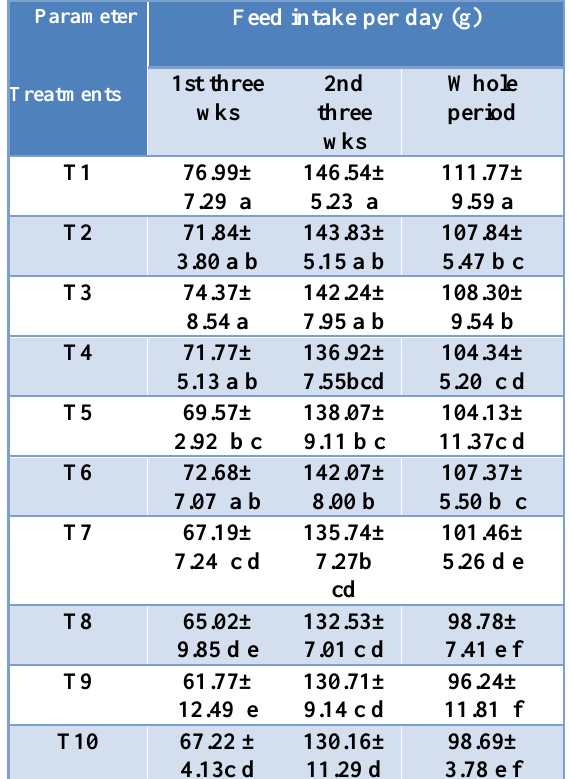
Table, 3: Effect of different levels of sweet basil powder on daily feed consumption (g / bird) during different three periods (M ± S.E)